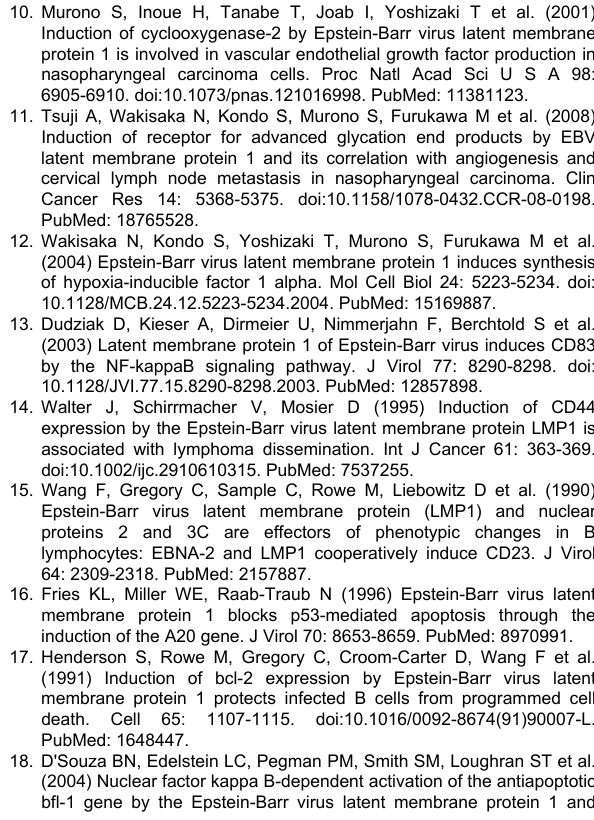
Figure S3. Immunohistochemical staining of endocan in NPC tissues. Mouse monoclonal antibody against endocan (purchased from Abnova) was used as primary antibody. The sections were color-developed with Super Sensitive Polymer- HRP IHC Detection System (BioGenex, San Ramon, CA, USA). The sections were counterstained with hematoxylin. The brown color represents endocan staining. Arrowheads indicate vascular endothelial cells. T, tumor cells. (PDF) Methods S1. Supplementary methods-cDNA microarray